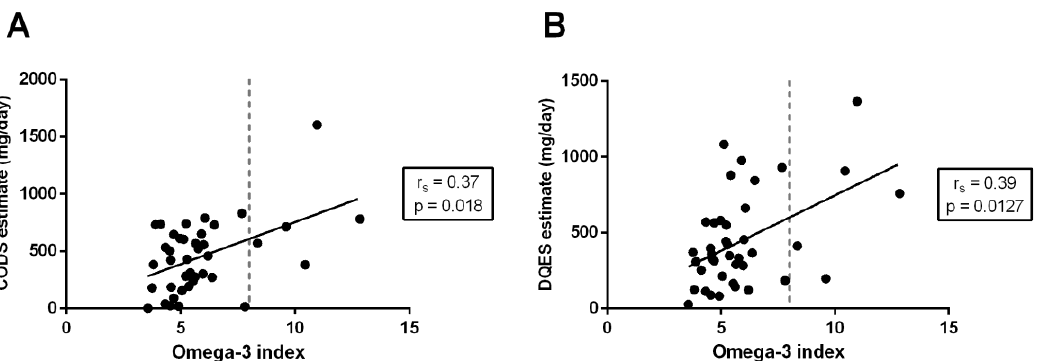
Figure 4. The relationship between the overall Omega-3 index, calculated as the total percentage (%) of EPA and DHA present in erythrocytes, and estimated using the dried blood spot (DBS) biomarker, and the dietary estimate of total long-chain omega-3 intake using ( A ) the Clinical Omega-3 Dietary Survey (CODS) and ( B ) the Dietary Questionnaire for Epidemiology Studies (DQES) v3.2. Correlation coefficients are calculated using the Spearman’s correlation coefficients (r s